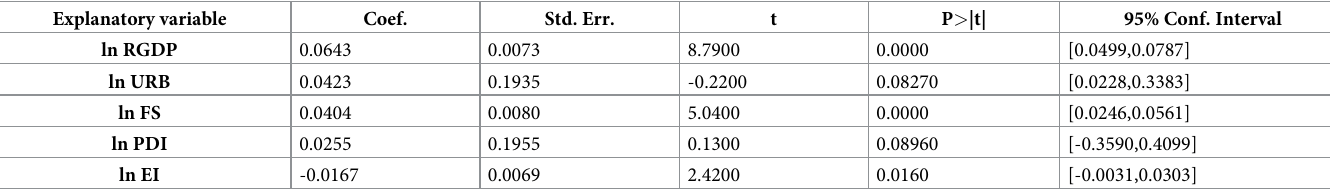
Table 5. Regression results of the Tobit model. Explanatory variable Coef. Std.